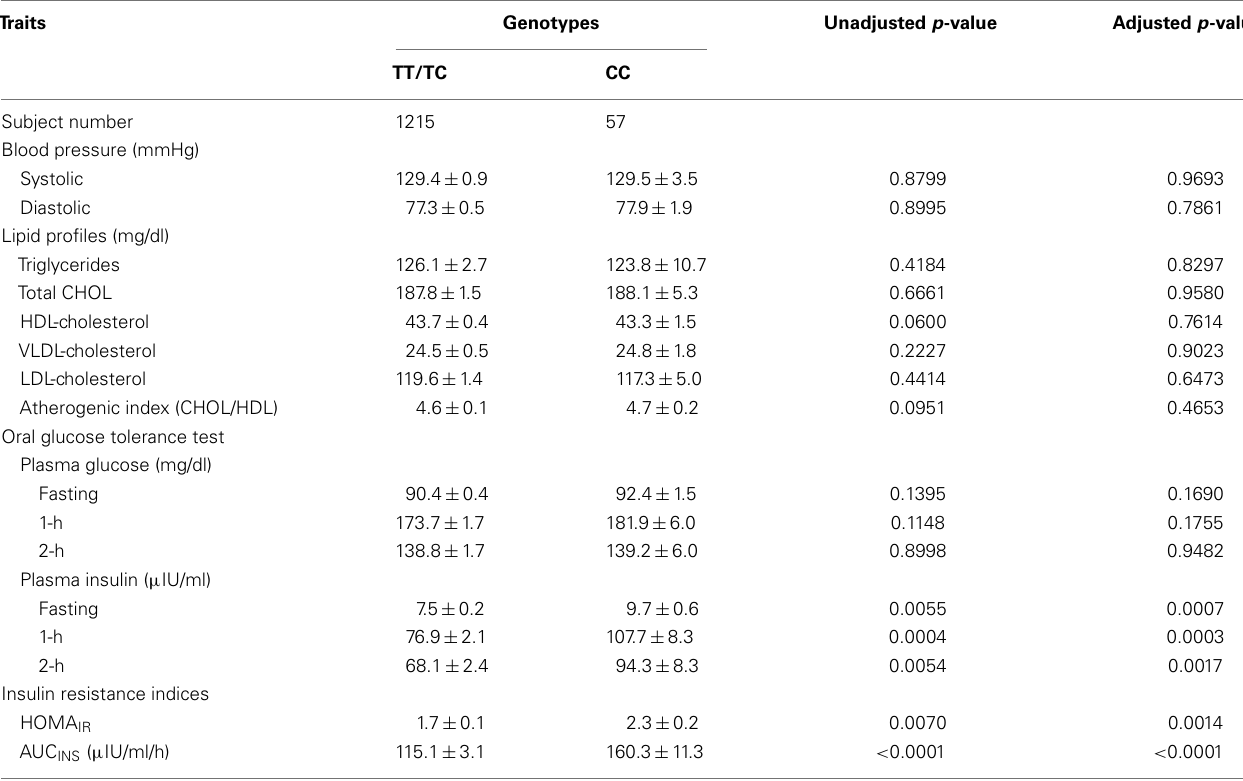
Table 3 | Clinical characteristics of the Chinese siblings with discordant ET A receptor genotypes are compared with or without adjustment for age, gender, and BMI (Mean ± SD)